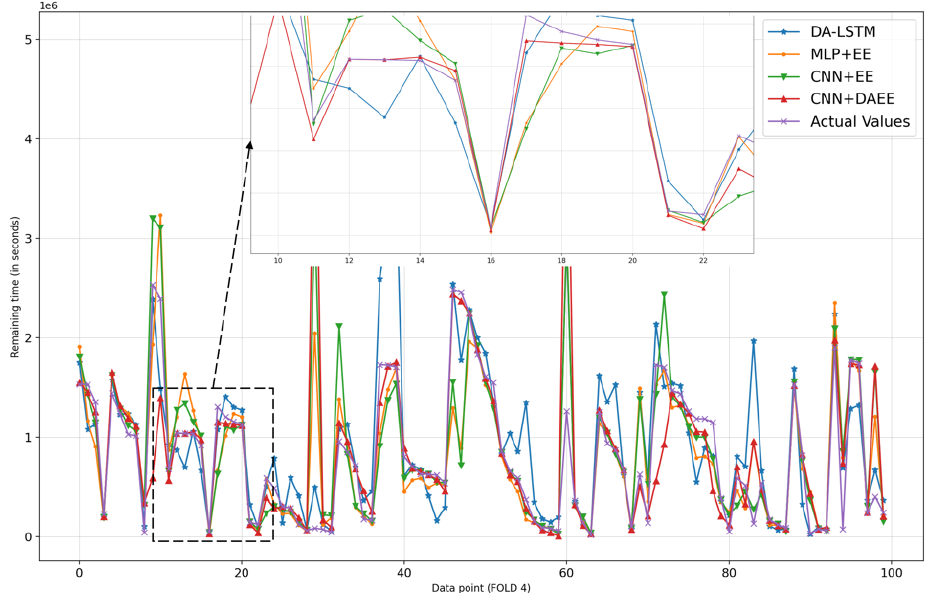
Figure 10. Comparison of results of four models for 100 sample test sets in fourth iteration of CV.